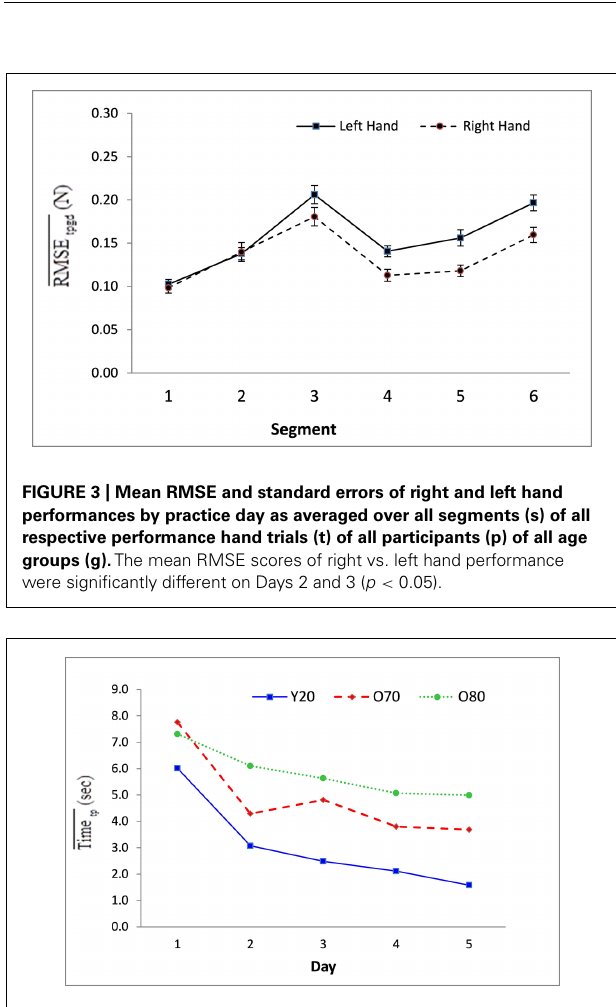
FIGURE 6 | Mean absolute asymmetry index and standard errors of the dependent variable Time for each of the six segments as averaged collectively over all participants (p) in every group (g) on every practice day (d). The mean AI time scores were significantly different on Segments 3 and 6 ( p <